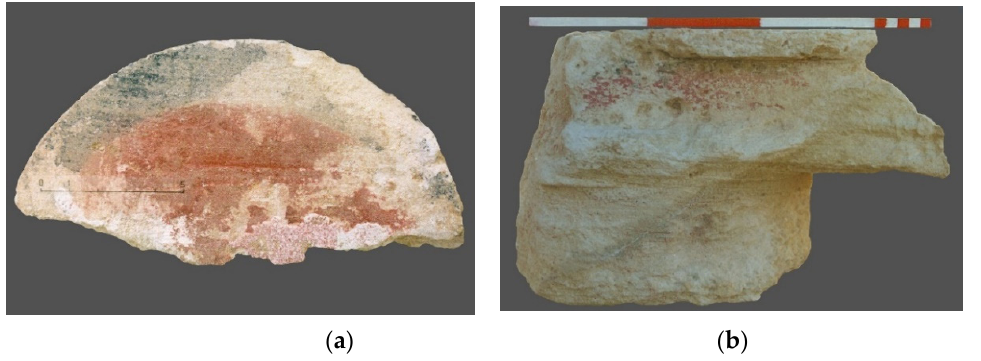
Figure 5. Fragments of pseudo-Ionic capitals with preserved traces of polychrome: ( a ) fragment of a volute from a pseudo-Ionic capital found in house H10E (photo Stanis ł aw Medeksza); ( b ) fragment of a pseudo-Ionic capital from house H10 (photo Rafa ł Czerner).